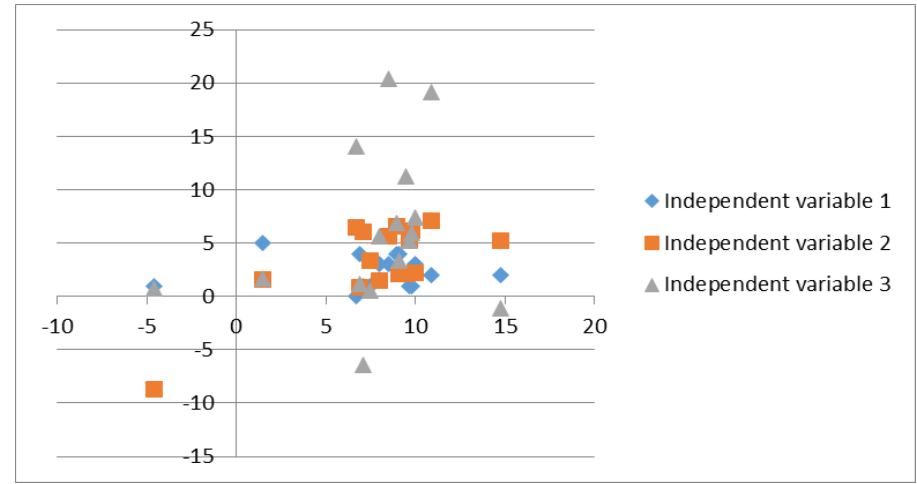
Figure 1: Verification of the model initial data for compliance with the assumption of linear